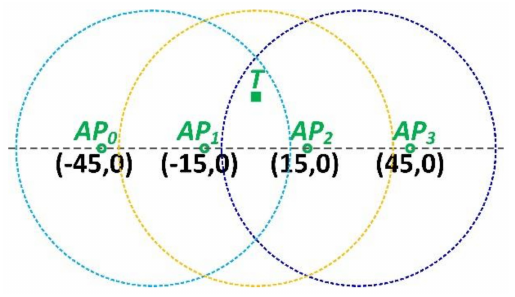
Figure 4. The roaming